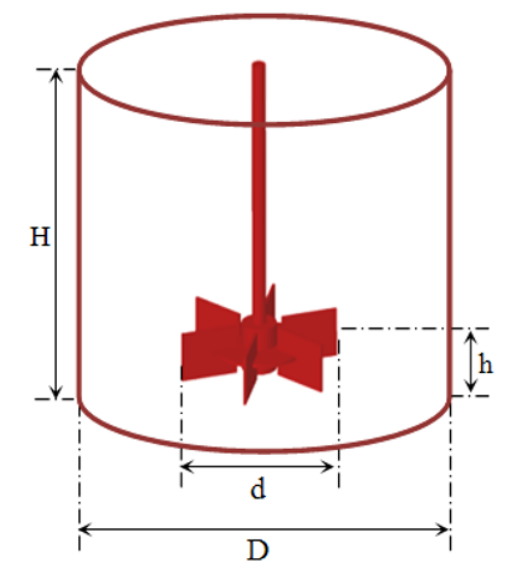
Figure 1. Stirred vessel configuration.